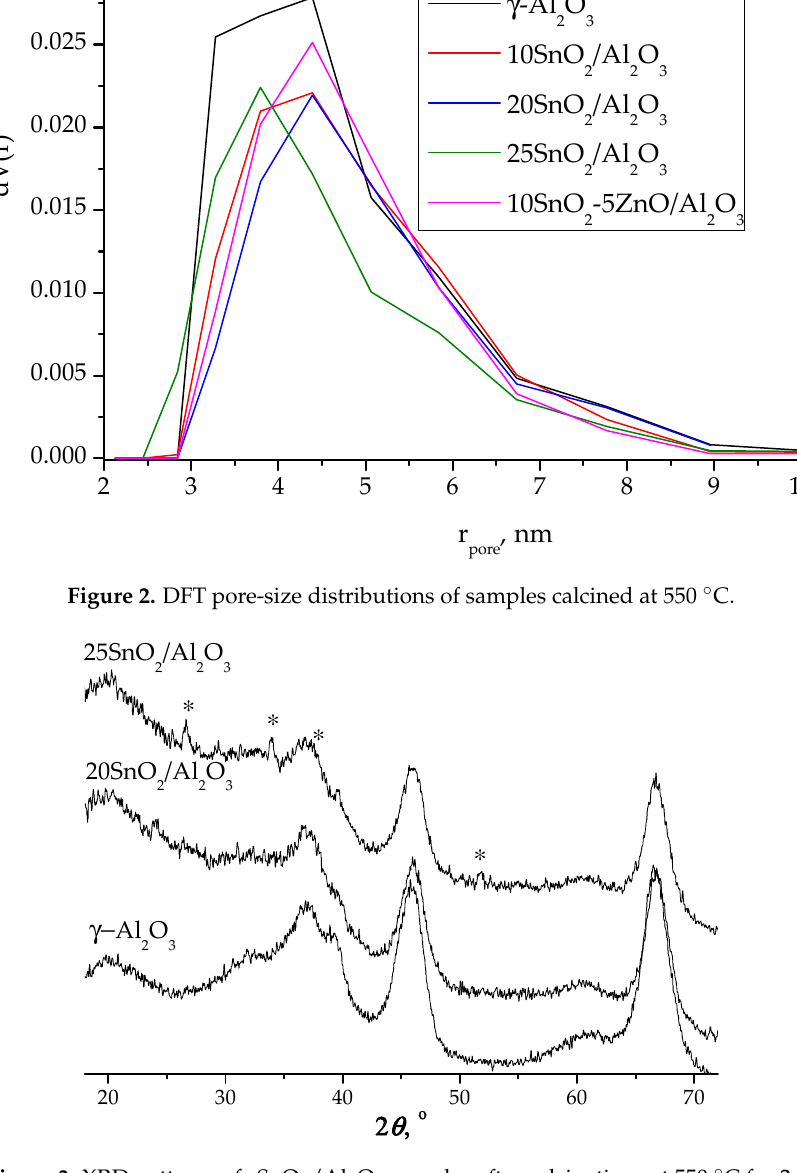
Figure 3. XRD patterns of z SnO 2 /Al 2 O 3 samples after calcinations at 550 °C for 2 h.